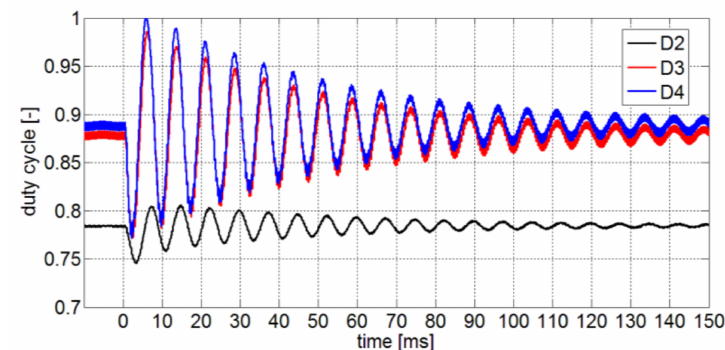
Figure 12. Duty cycles transient in Case